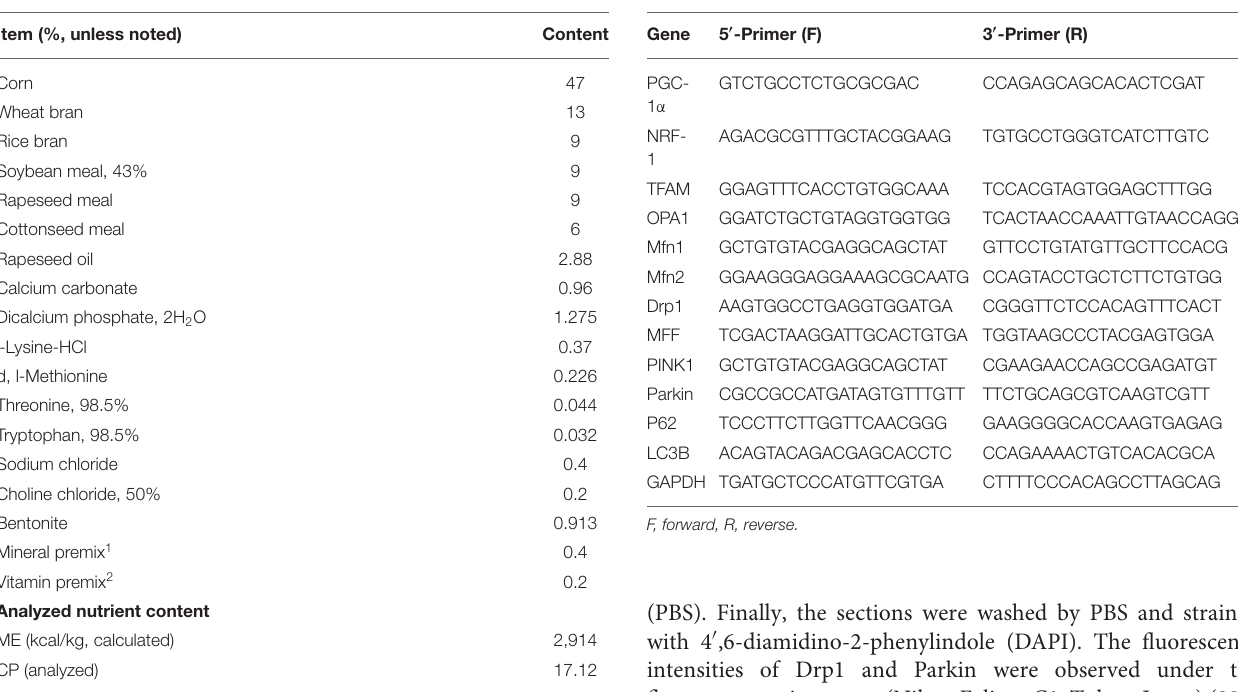
TABLE 1 | The component and nutritional levels of the basal diet. TABLE 2 | Premier sequences used for real-time